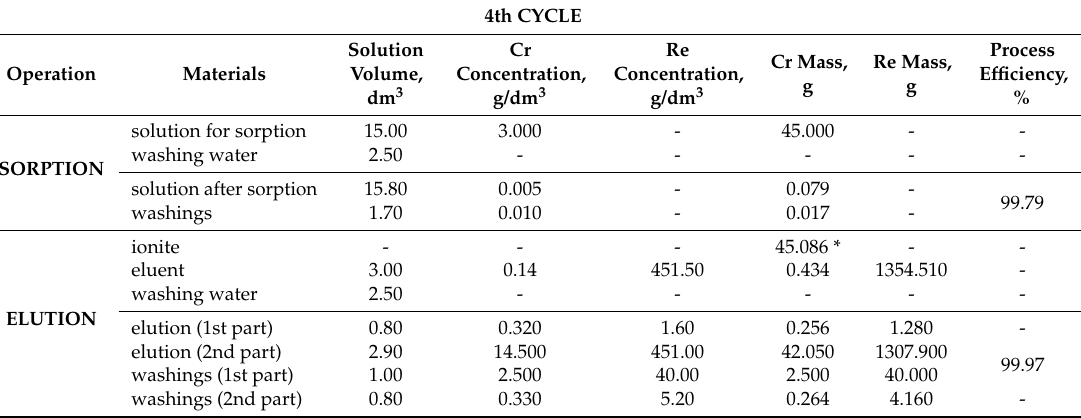
Table 4. Chromium(III) sorption and elution balance—4th cycle.